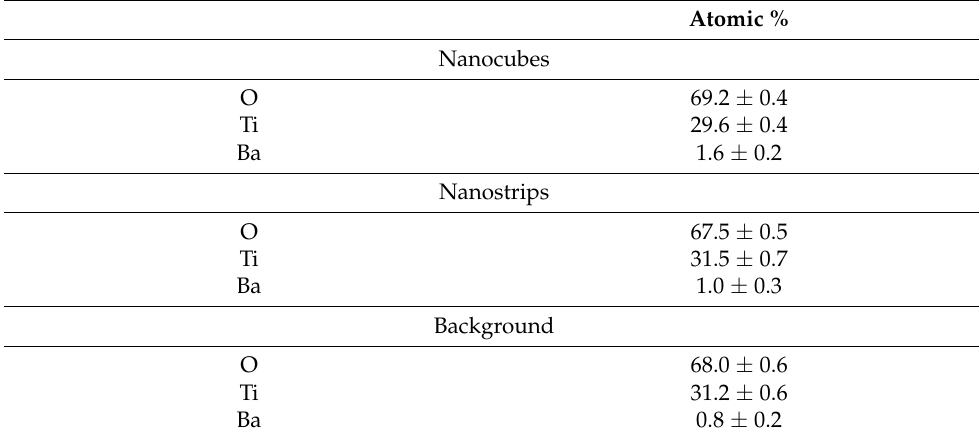
Figure 3. The XRD analysis demonstrated that anatase (ICDD PDF#21–1272) is the main crystalline phase in all samples. Fluorine-doped tin oxide (FTO) (ICDD PDF#41 −